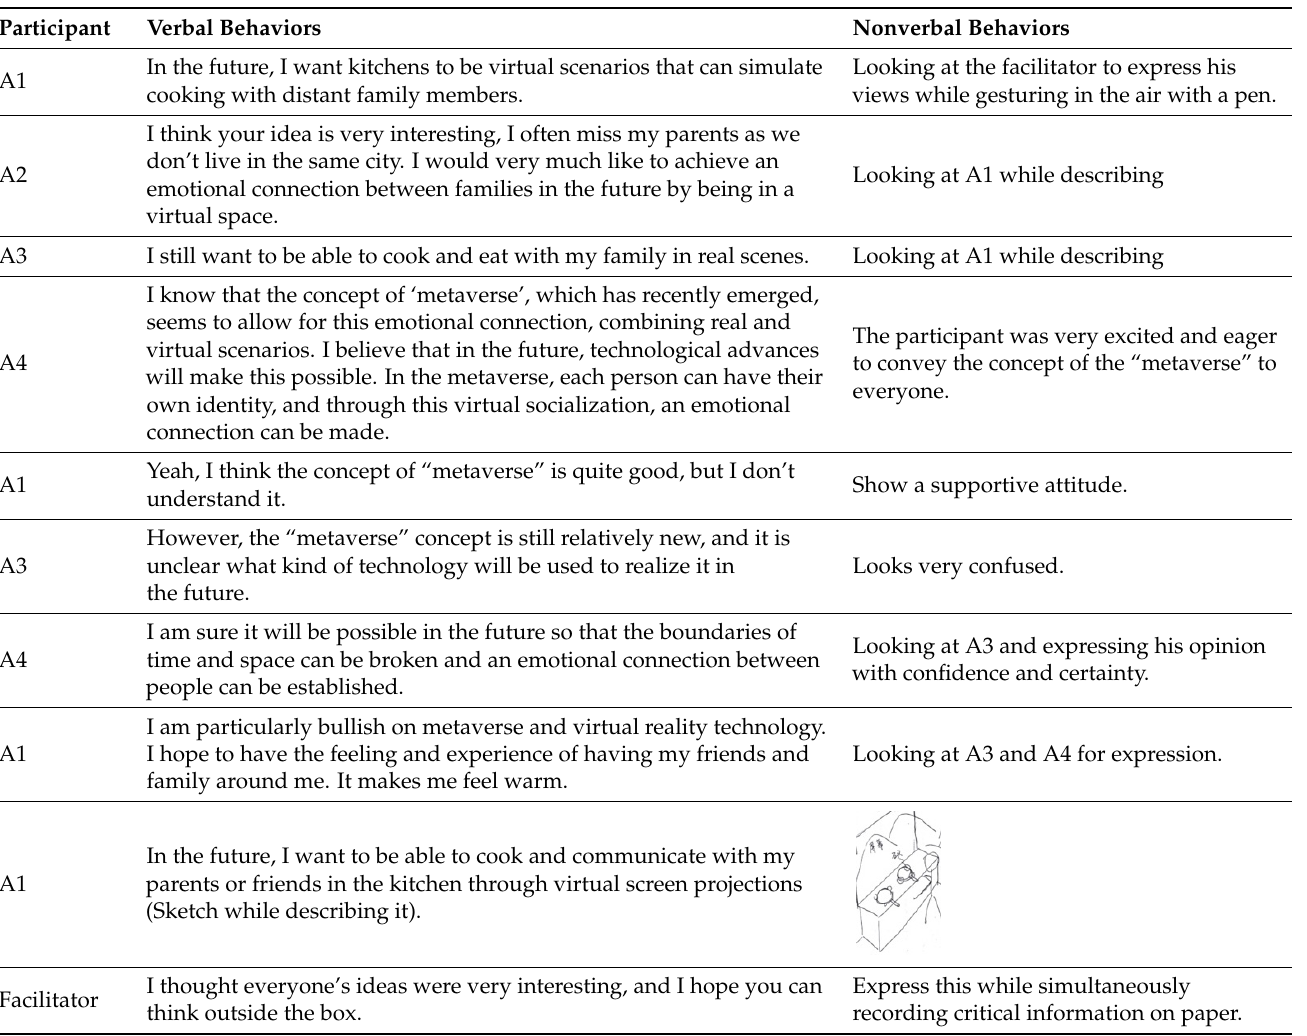
Table 3. An example of the Group Interaction and Creations process.